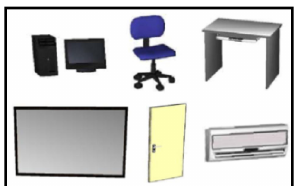
Figure 9. The object models in GIS Lab